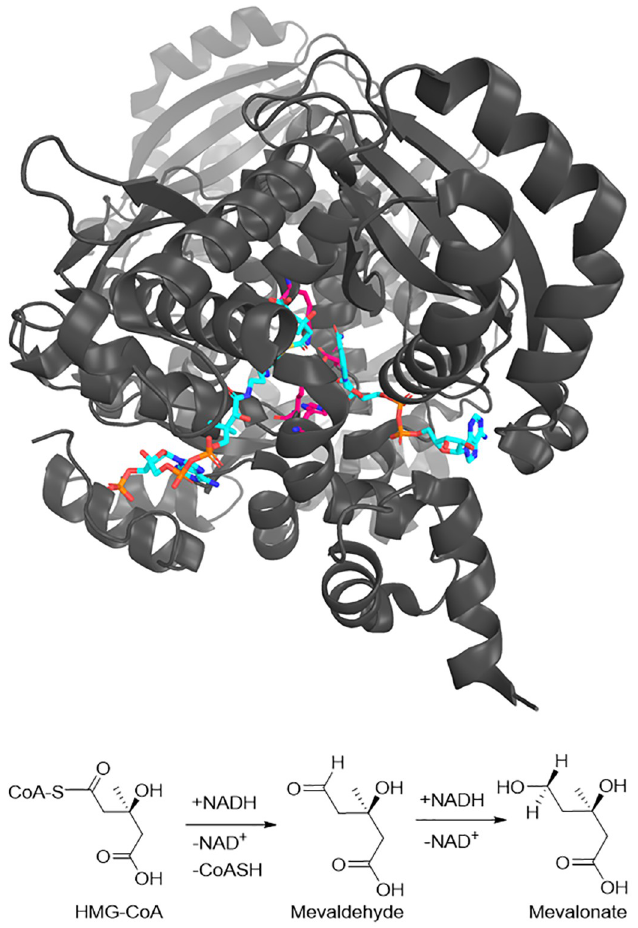
Fig 1. Structure of Pm HMGR (pdb code 1QAX, 2.80 Å resolution). The crystallized substrate (HMG-CoA) and cofactor (NAD), shown in cyan, bound to the active site of HMG-CoA reductase (top). Double hydride transfer catalyzed by PmHMGR